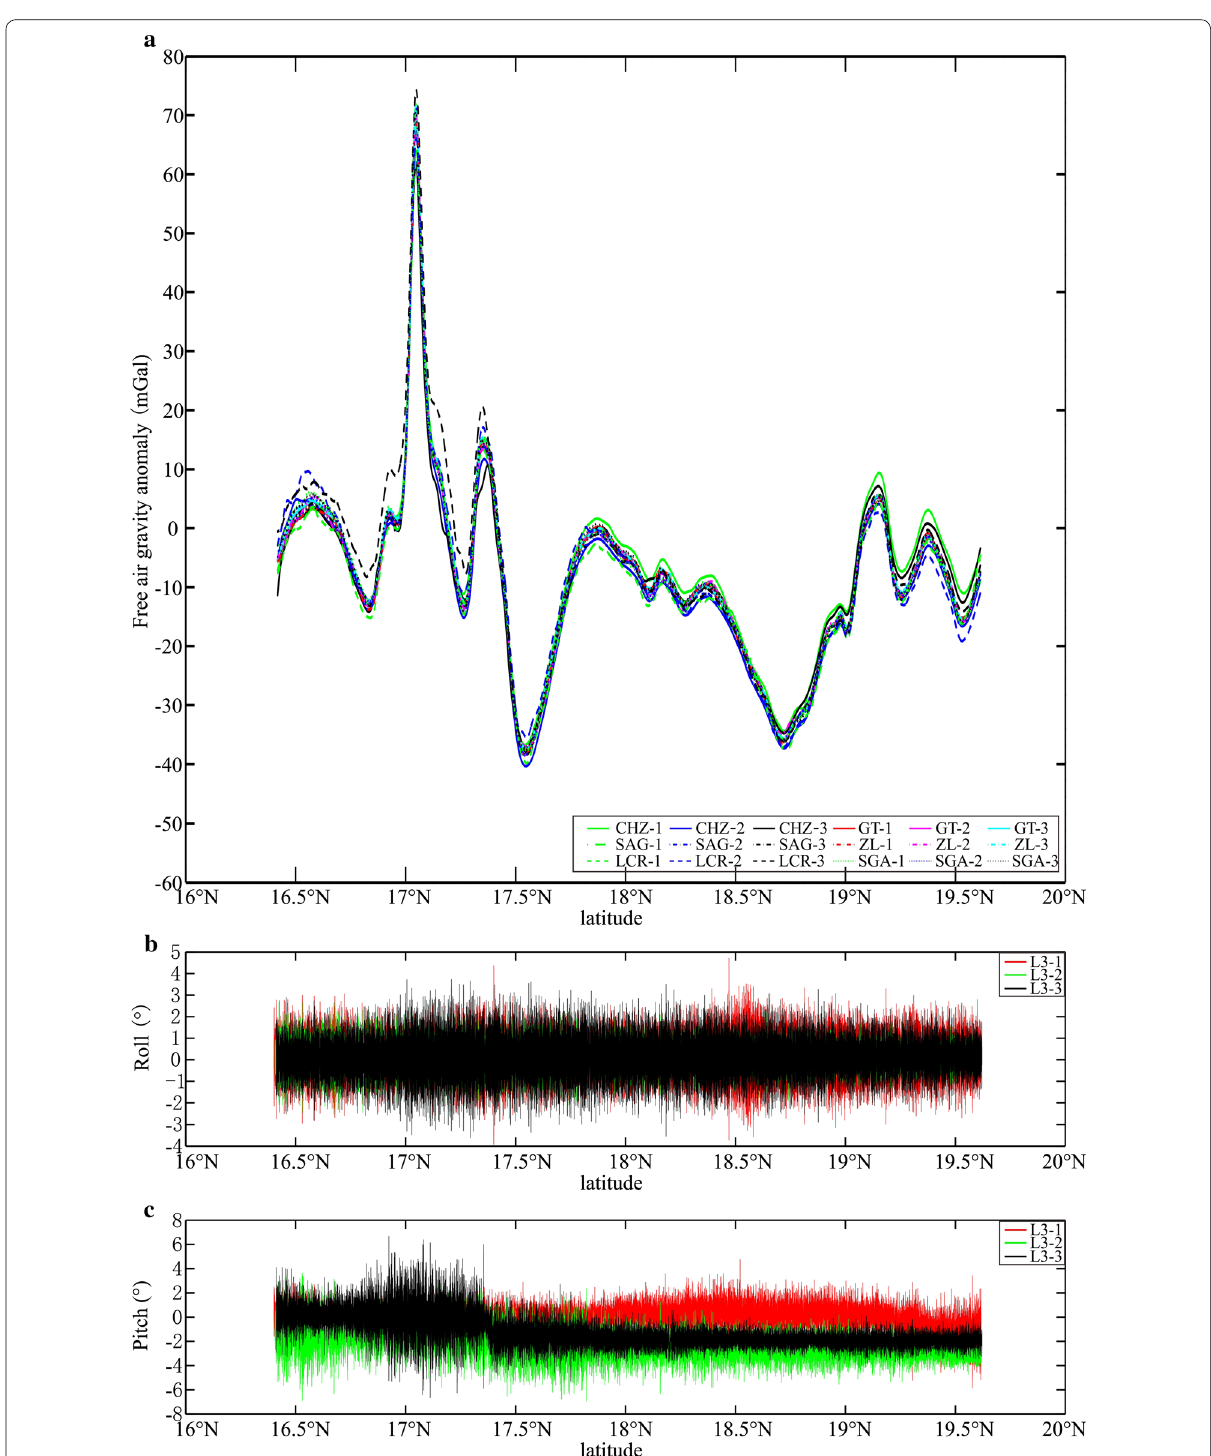
Fig. 6 Comparison of free-air gravity anomaly ( a ) results from measurements collected with all the gravimeters on the three times repeated Line 3 (ref. to Fig. 3); b , c sea conditions during the survey can be envisaged from roll and pitch vessel